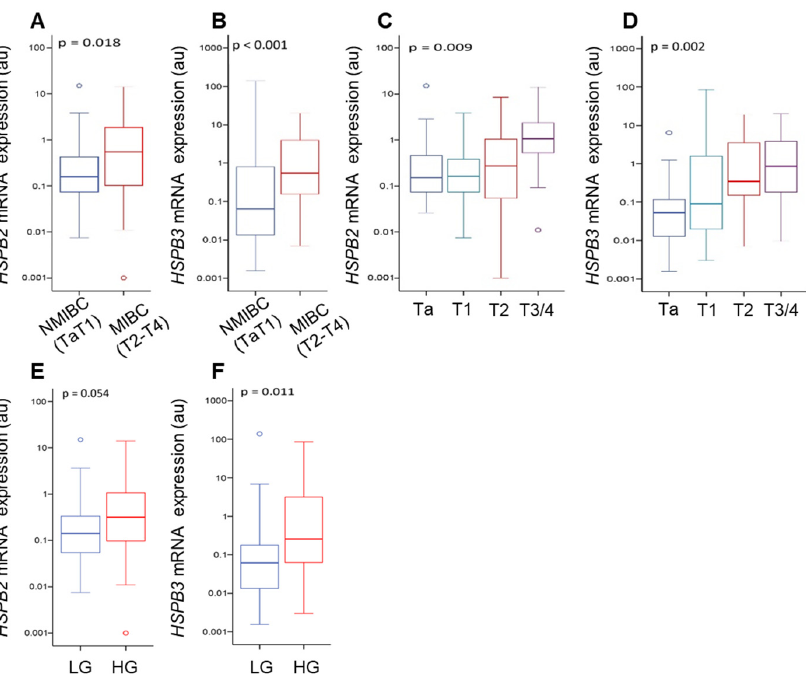
Figure 3. HSPB2 and HSPB3 mRNA expression analysis in BlCa patients. Box plots presenting the correlation of HSPB2 and HSPB3 genes expression in the screening cohort ( n = 100) with non-muscle invasive (NMIBC) and muscle invasive (MIBC) bladder cancer ( A , B ), as well as with tumor stage ( C , D ) and tumor grade ( E , F ). The middle lines inside the boxes indicate the median (50th percentile or second quartile), while the lower and the upper box boundaries represent the 25th percentile (first quartile) and the 75th percentile (third quartile), respectively. The lower and upper whisker extend to the lowest and highest value, respectively, within the 1.5× interquartile range (box height) from the box boundaries. p -value was calculated using the Mann–Whitney U ( A , B , E , F ) and Kruskall–Wallis ( C , D ) tests.